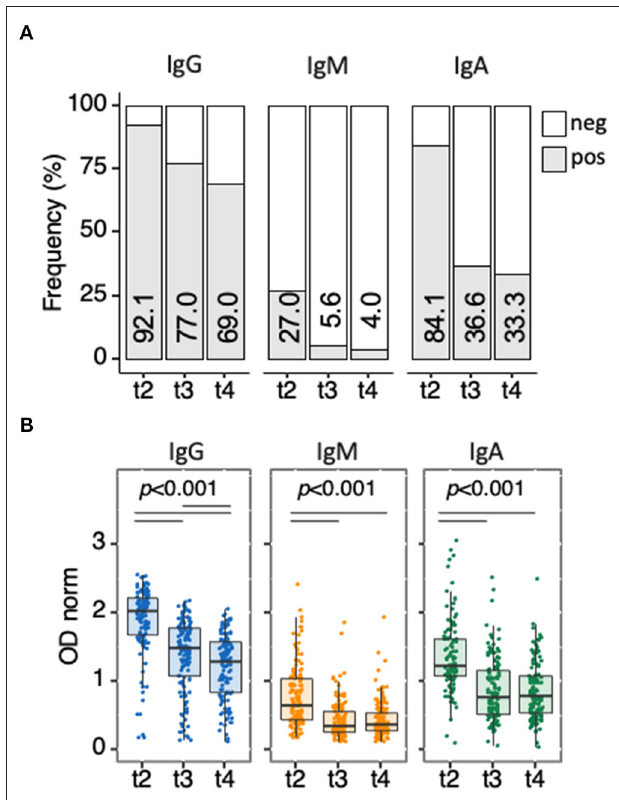
FIGURE 6 | Waning of anti-spike antibody responses along time. Follow-up analysis of antibody responses for anti-spike IgG, IgM, and IgA antibodies in HD patients ( n = 126) collected at t2, t3, and t4. (A) Seroconversion is determined and presented as in Figure 2 . Pearson’s Chi-squared test (with Yates’ continuity correction) was used to determine differences over time. (B) anti-spike antibodies in patients, determined and presented as in Figure 3 . Differences were determined by the Quade test for antibody levels along time (all 3 panels), the Wilcoxon signed-rank test for pairwise comparison in each panel ( p- values indicated by horizontal black bars). Detailed p- values presented in Supplementary Table 10 . t2, sera collected 42 days post-first vaccine dose; t3, sera collected ∼ 140 days post-first vaccine dose; t4, sera collected 180 days post-first vaccine